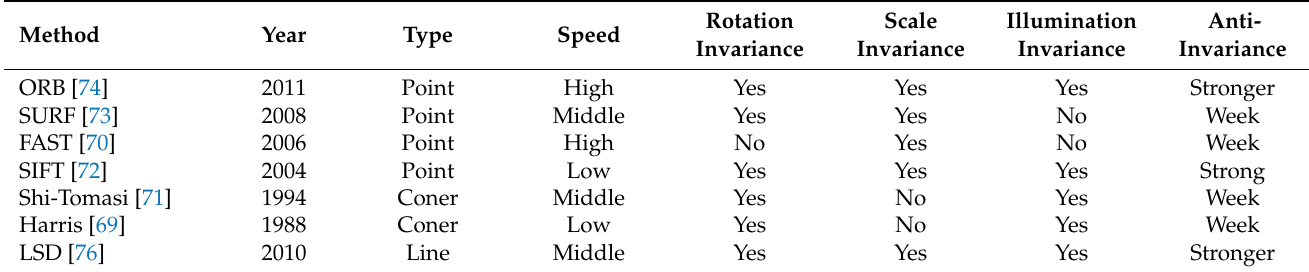
Table 3. Comparison table of commonly used feature extraction